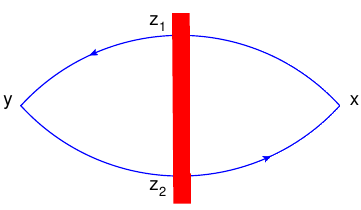
Figure 1 . Diagram for the LO impact factor. We indicate in blue the quantum fields and in red the classical background